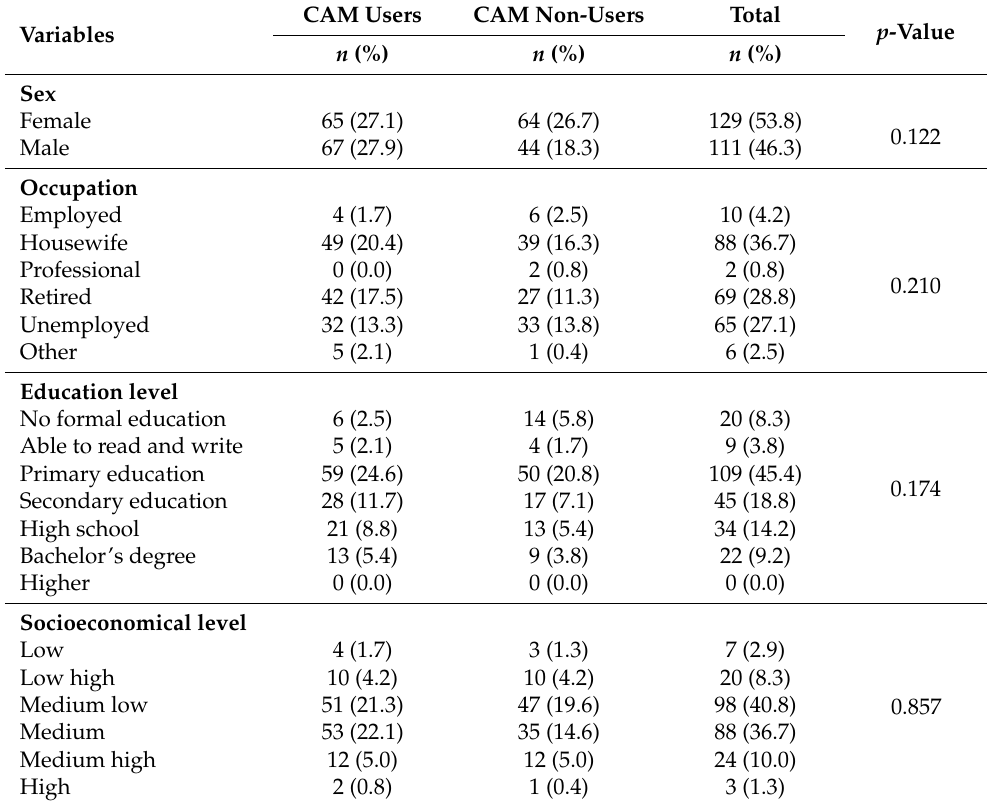
Table 1. Sociodemographic characteristics of patients.